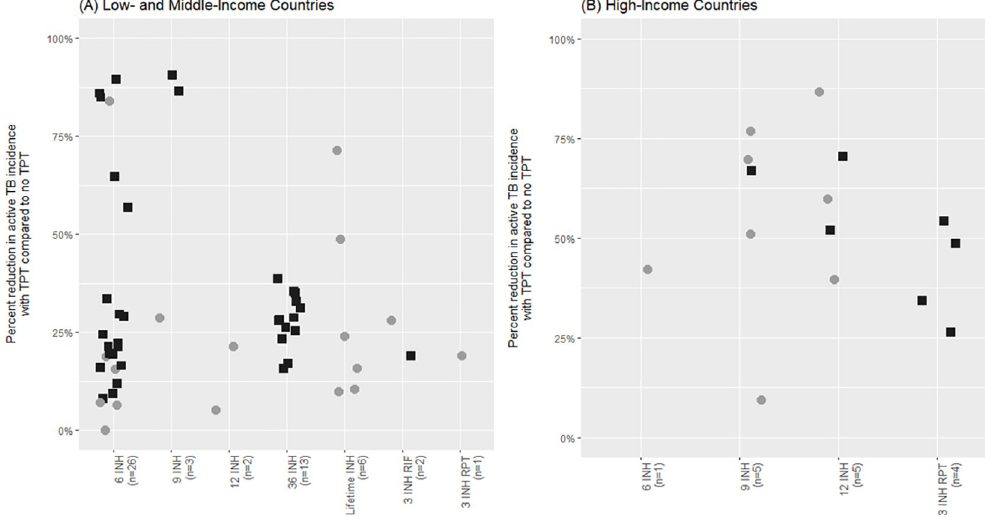
Fig 2. Percent reduction in active TB incidence in studies comparing TPT versus no TPT, by TPT regimen and country- level income. INH, isoniazid; RIF, rifampin; RPT, rifapentine; TB, tuberculosis; TPT, tuberculosis preventive therapy. Each data point represents a study arm. Modeling methods are distinguished in this figure; filled black squares ( ■ ) represent decision analysis models, while filled gray circles ( ● ) represent transmission models.